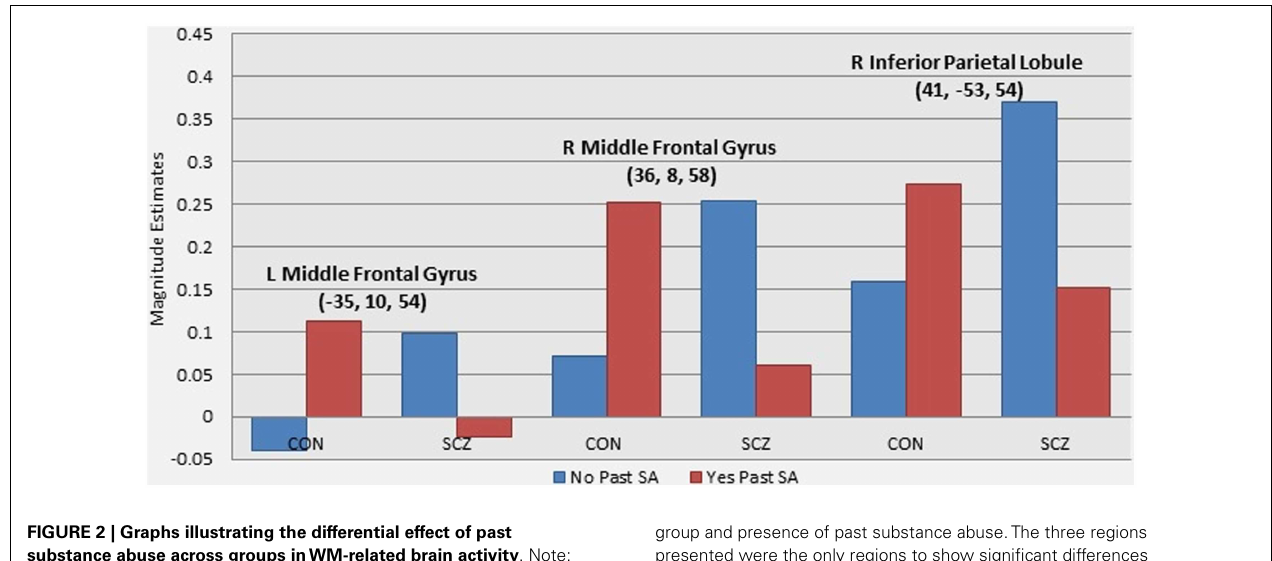
FIGURE 2 | Graphs illustrating the differential effect of past substance abuse across groups inWM-related brain activity . Note: these graphs present magnitude estimates from follow up analyses of the patterns of activation driving the interaction effect of diagnostic